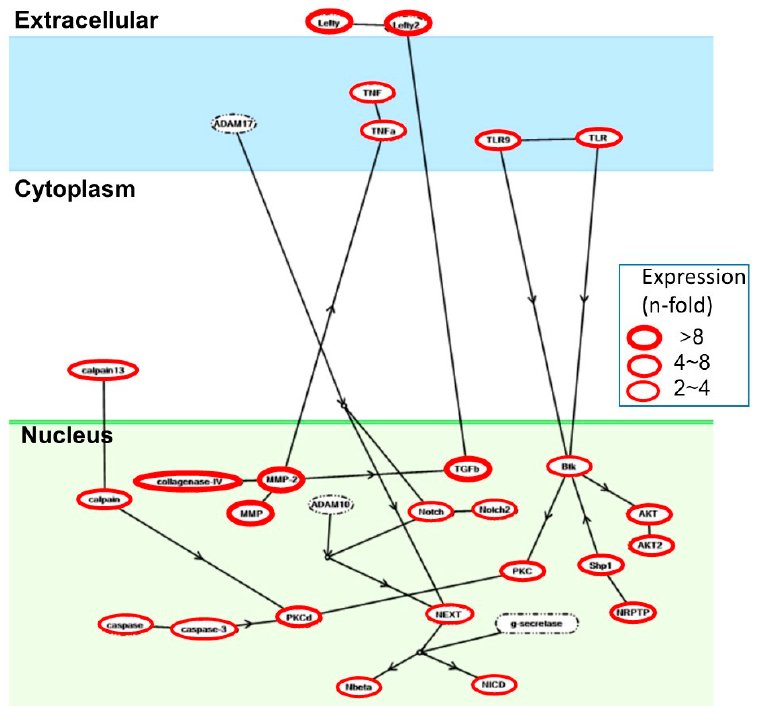
Figure 5. Enhanced mRNA expression of tumor necrosis factor superfamily, member 2 (TNFA), RAC serine/threonine-protein kinase (AKT), caspase 3 (CASP3), and CXC motif chemokine (CXCl13) on the TNF pathway by IL1- β —.